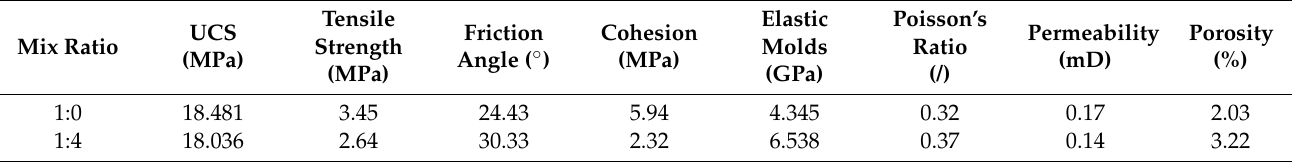
Figure 3. Model block preparation for hydraulic fracture test. ( a ) Unit blocks were pasted to each other to form a big cubic block. ( b ) Big cubic block layered in the center of a metal mold; ( c ) Model blocks filled with paste cement to form an ensemble; ( d ) Metal perforation casing installed into the model block. ( e ) Structure of the perforation casing used in the experiment. Table 2. Strength properties of interface between block